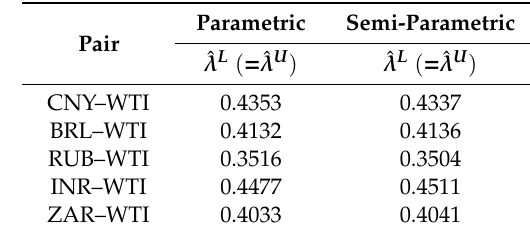
Table 12. Tail dependence coe ffi cients of the Student’s t copula